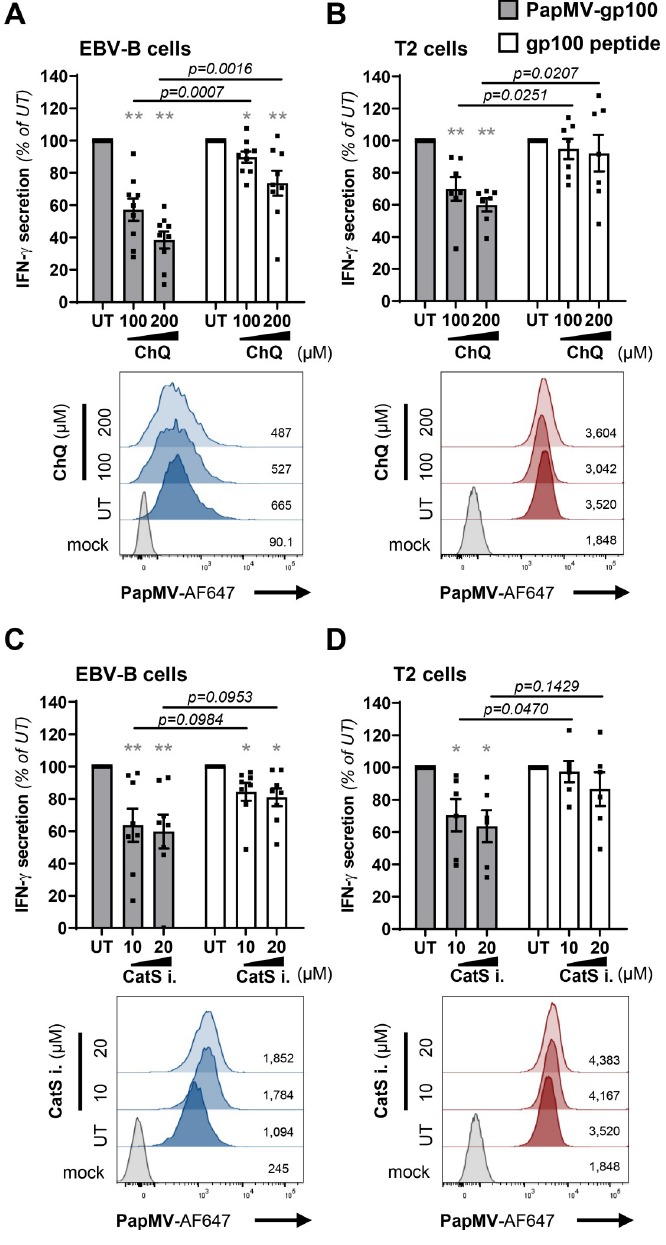
Fig 2. Inhibition of cathepsin S and endocytic acidification abrogate MHC class I cross-presentation mediated by PapMV VLPs. (A-D) Top panel: EBV-B and T2 cells were pretreated for 1 hour with chloroquine (ChQ) (A, B) or a cathepsin S specific inhibitor (CatS i.) (C, D ) at indicated concentrations. PapMV-gp100 (25 μ g/mL) or gp100 peptide (1 μ M) was added to pretreated cells without washing and cells were incubated for 6 hours at 37˚C. Cells were washed and co-cultured with gp100-specific CD8 + T lymphocytes for 16–18 hours at a 1:1 ratio. Supernatants were collected and IFN- γ was quantified by ELISA to evaluate MHC-I antigen cross-presentation. Results are presented as mean ± SEM, % of IFN- γ secretion of untreated (UT) cells. Data were pooled from nine (A), seven (B) , eight (C) or six (D) independent experiments. Statistical significance (defined at p < 0.05) was calculated using one sample t test ( � p < 0.05, �� p < 0.01). When comparing PapMV VLP cross-presentation with the cross-presentation of the control peptide at corresponding inhibitor concentration, statistical significance (defined at p < 0.05) was calculated using a two-tailed unpaired Student’s t-test; p values are indicated. (A-D) Bottom panel: PapMV labeled with Alexa Fluor 647 (PapMV-AF647, 10 μ g/mL) was added for 3 hours and internalization was assessed by flow cytometry. Histograms represent PapMV endocytosis and are representatives of two (A, B, D) or three (C) independent experiments. Numbers indicate PapMV-AF647 MFI from the representative experiment showed.